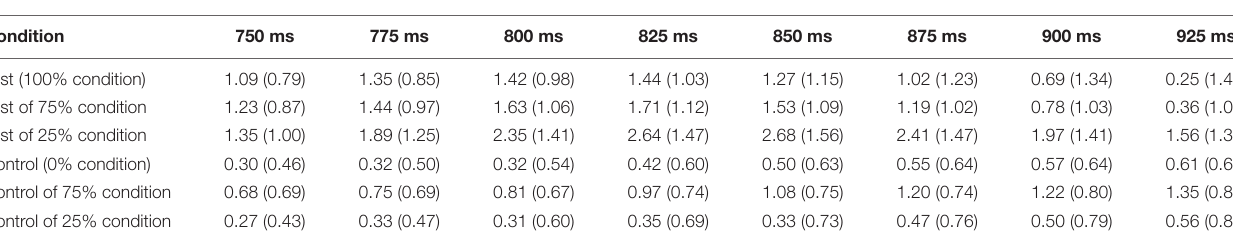
FIGURE 4 | Time course of the peak latency of 40-Hz auditory steady-state response (ASSR). Mean peak latency of each ASSR sine wave is plotted for each time point. Results for ASSR to the test stimulus (A) and control stimulus (B) are shown. Probability refers to that for the test stimulus. TABLE 2 | Mean latency shift of auditory steady state response for all